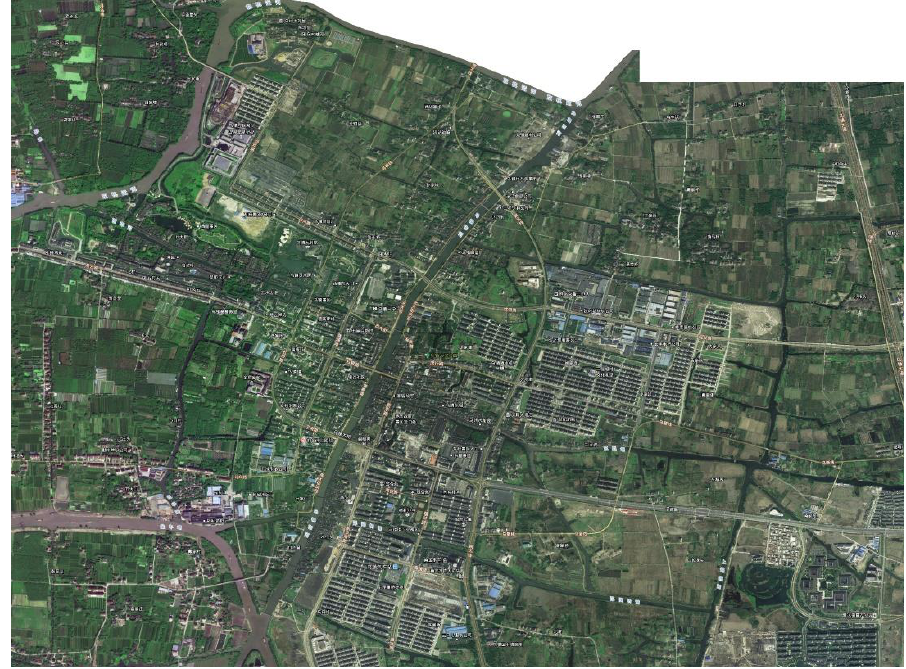
Figure 9. Wuzhen ancient town area map (Source: http://www.zjditu.cn/, accessed on 12 October 2019).